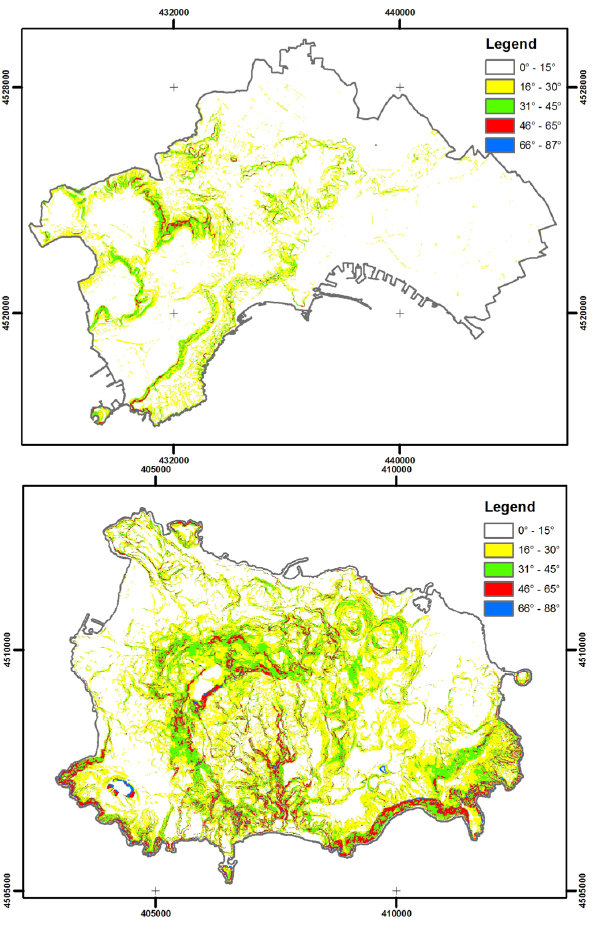
Fig. 16. Relative hazard (a) and risk (b) maps of Naples (after BANCR, 2010, modified). Hazard map legend: (1) low relative haz- ard; (2) medium relative hazard; (3) high relative hazard. Risk map legend: (1) moderate risk; (2) medium risk; (3) high risk; (4) very high